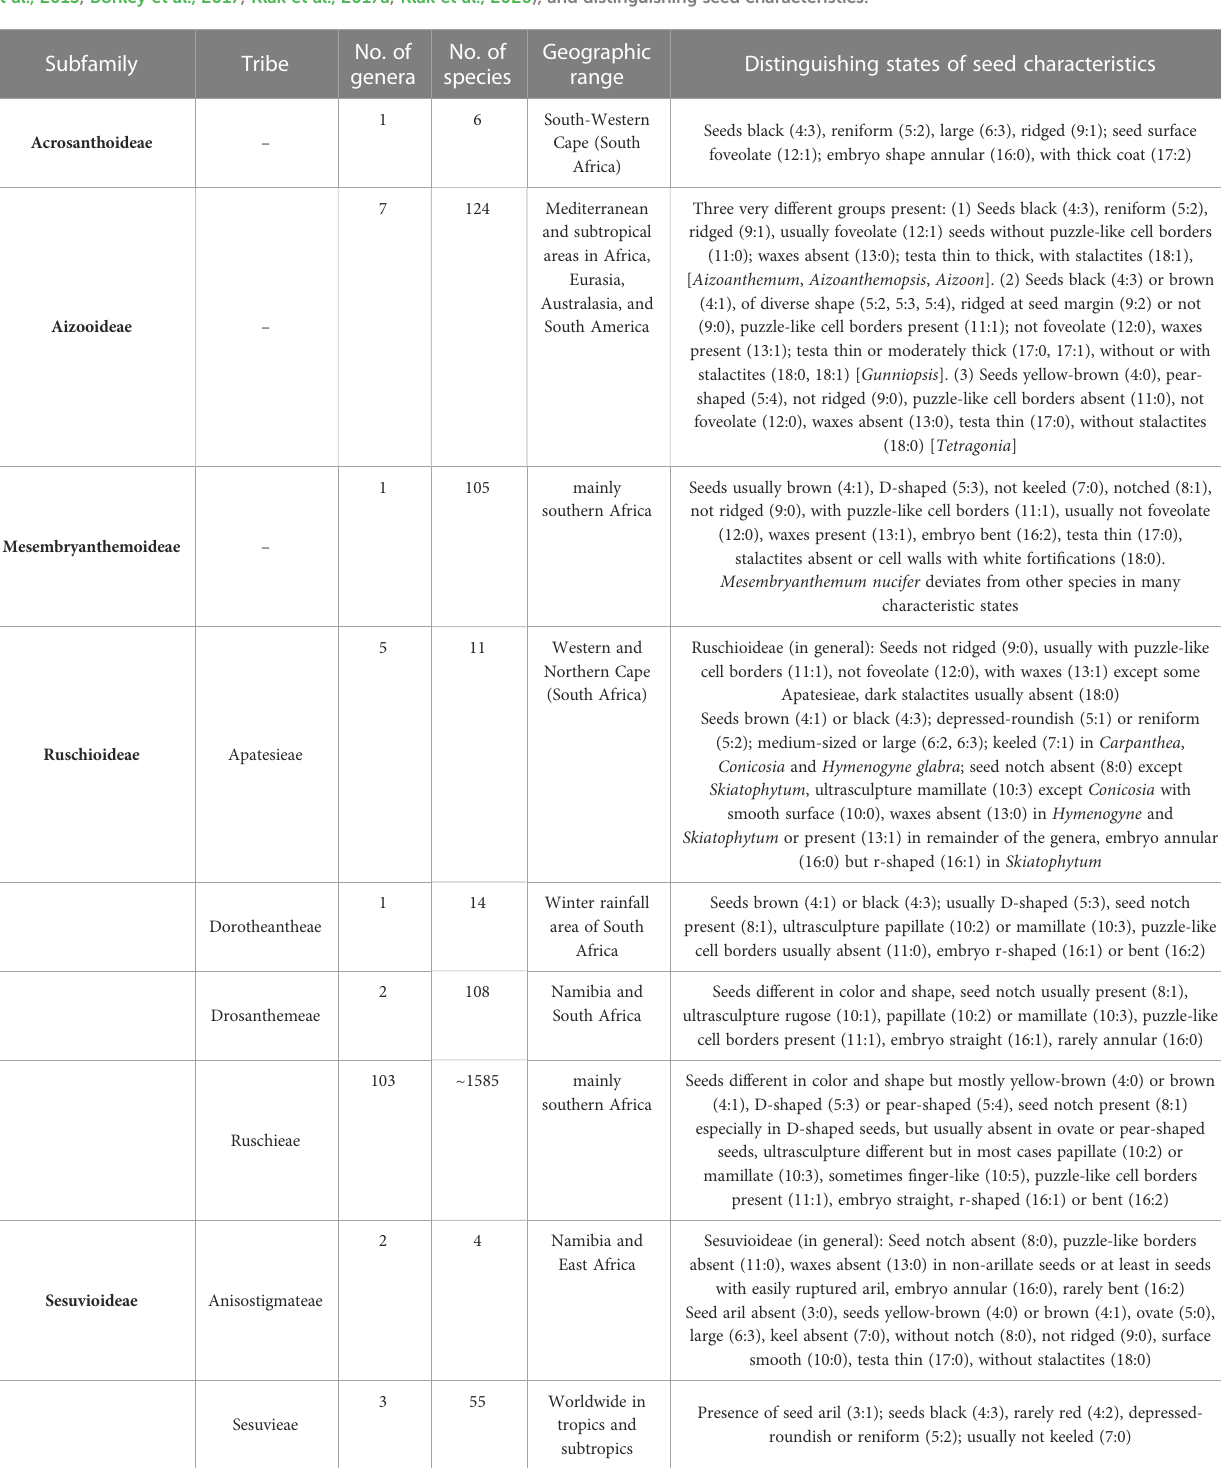
TABLE 1 Number of genera and species in subfamilies and tribes of Aizoaceae, their geographic ranges (Klak and Bruyns, 2012; Herna ́ ndez-Ledesma et al., 2015; Bohley et al., 2017; Klak et al., 2017a; Klak et al., 2020), and distinguishing seed characteristics.